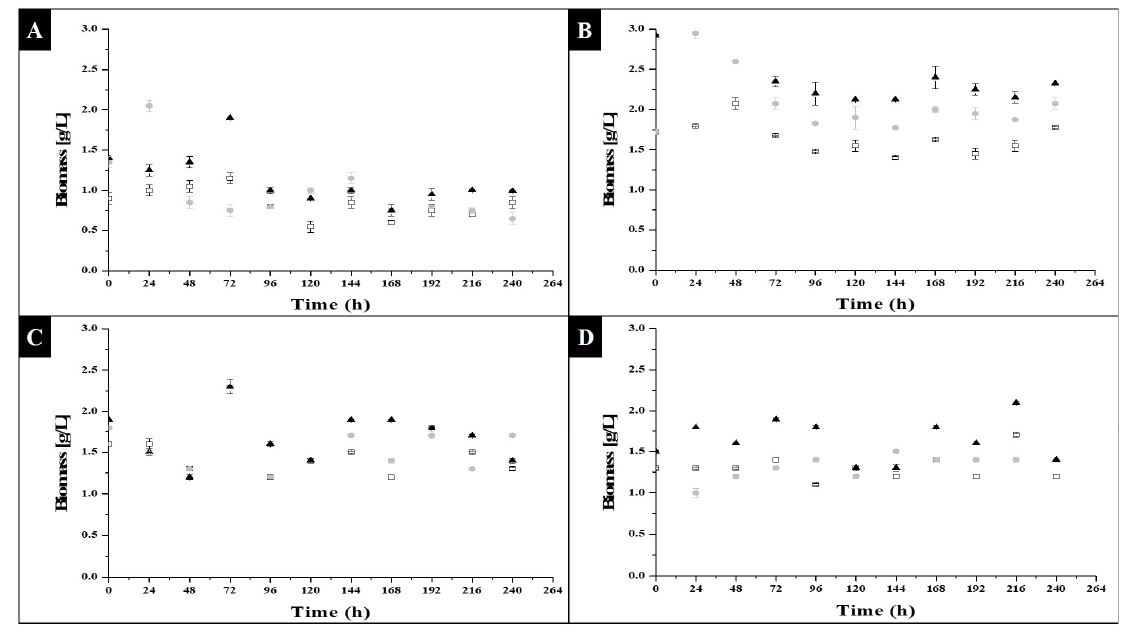
Figure 2. Biomass of C. vulgaris under photoheterotrophic growth: ( A ) sodium acetate in 8 light hours and 16 darkness photoperiods; ( B ) sodium acetate in 16 light hours and 8 darkness photoperiods. (cid:3) 0.0005 g/L, • 0.001 g/L and (cid:78) 0.0015 g/L sodium acetate concentration; ( C ) glycerol in 8 light hours and 16 darkness photoperiods; ( D ) glycerol in 16 light hours and 8 darkness photoperiods. (cid:3) 0.27 g/L, • 0.33 g/L and (cid:78) 0.44 g/L glycerol